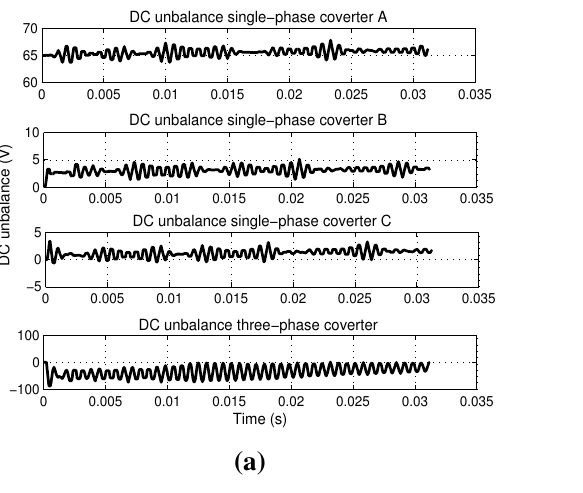
Figure 8. Single-phase balancing circuit operation. ( a ) DC voltage unbalance with pre-charge voltage in single-phase converter A set to +65 V; ( b ) result with an initial unbalance set to +65 V with balancing circuit.